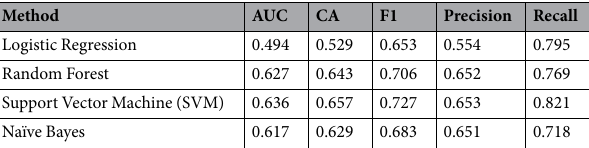
Table 4. Stratified 10-fold Cross validation for the neuropsychological assessment battery. a AUC (Area under the ROC curve) is the area under the classic receiver-operating curve. CA (Classification accuracy) represents the proportion of the examples that were classified correctly; F1 represents the weighted harmonic average of the precision and recall (defined below); Precision represents a proportion of true positives among all the instances classified as positive. In our case, the proportion of a condition was identified correctly; Recall represents the proportion of true positives among the positive instances in our data.